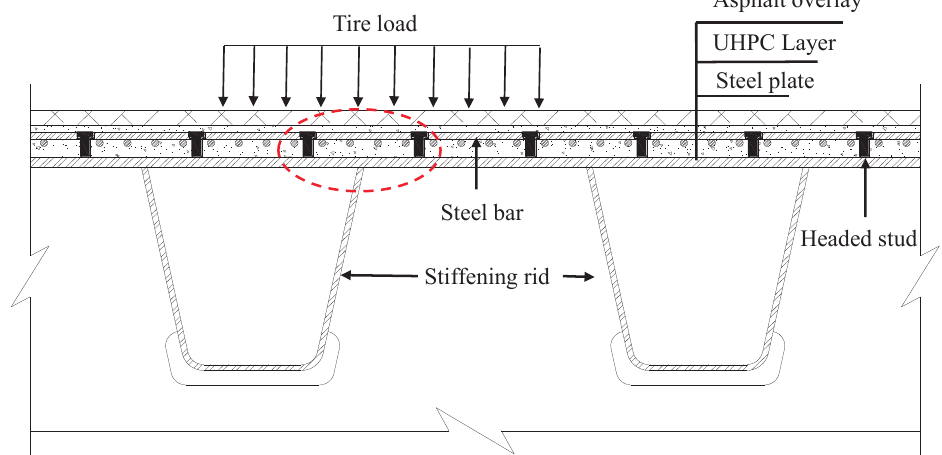
Figure 1. Schematic diagram of wheel riding